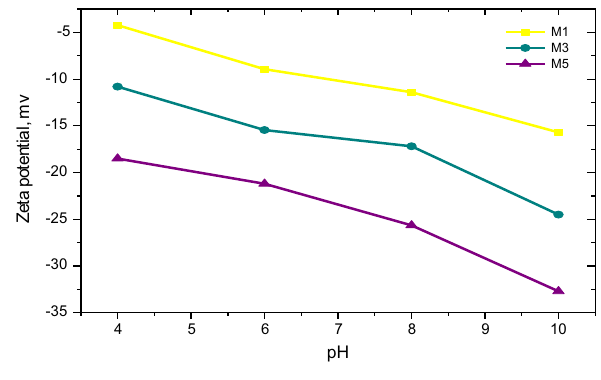
p and MWCO of the fabri-